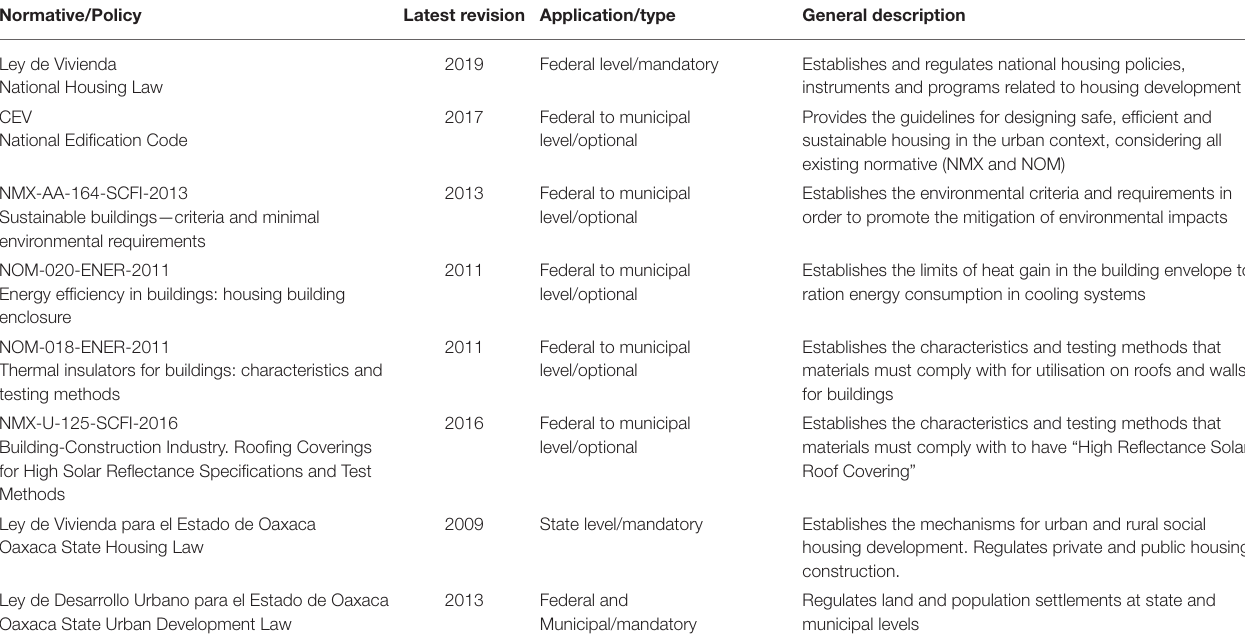
TABLE 6 | Summary of retrofitting strategies in